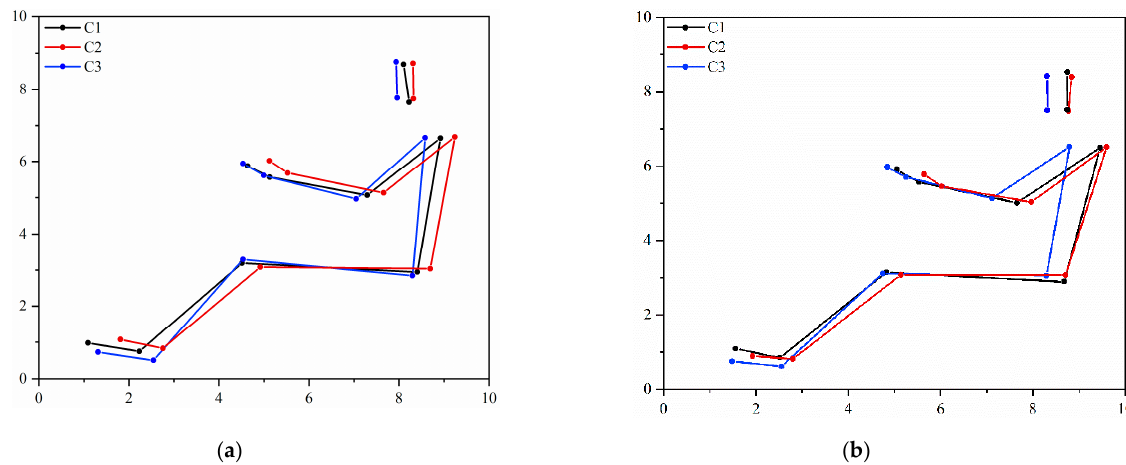
Figure 2. Illustration of the preferred driving postures between the subgroups at the initial and final recording. Note. C1—Cluster 1; C2—Cluster 2; C3—Cluster 3. ( a ) 5th minute of steering; ( b ) 120th minute of steering.